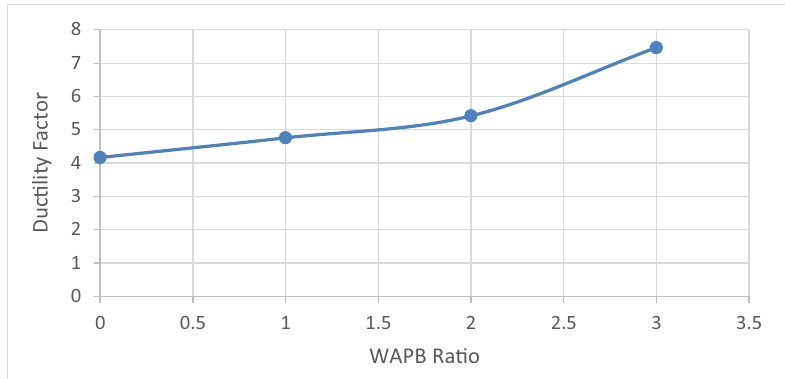
Figure 8: E ff ect of WAPB on ductility factor.